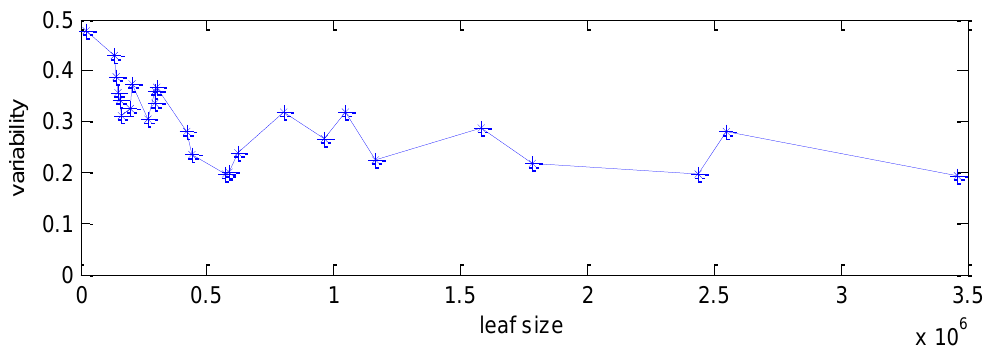
Figure 13. Variability of several images in function of the leaf